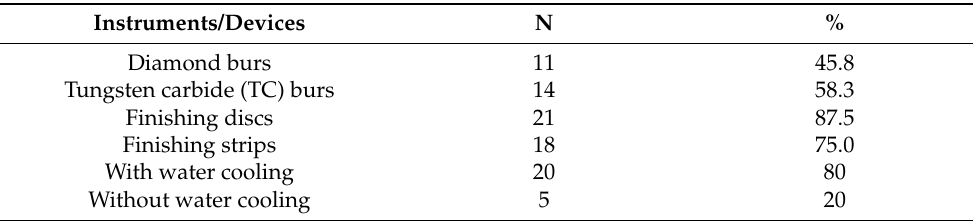
Table 5. Taught finishing technique/materials for posterior restoration taught in Malaysia ( n =